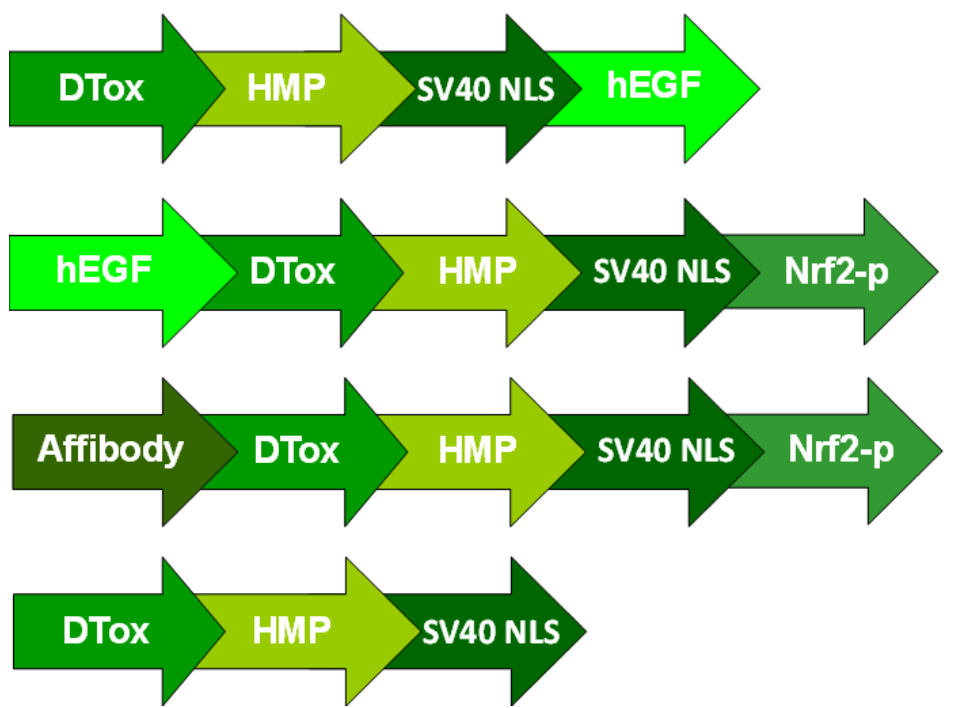
Figure 1. Schematic presentation of different MNTs used in this study. DTox — translocation domain of diphtheria toxin; HMP — E. coli hemoglobin like protein (carrier module), SV40 NLS — an optimized SV-40 nuclear localization sequence; hEGF — human epidermal growth factor, Affibody — antibody-like EGFR affibody polypeptide, Nrf2-p — functional polypeptide sequence from nuclear factor erythroid 2-related factor 2 (Nrf2) for interaction with intracellular proteins.